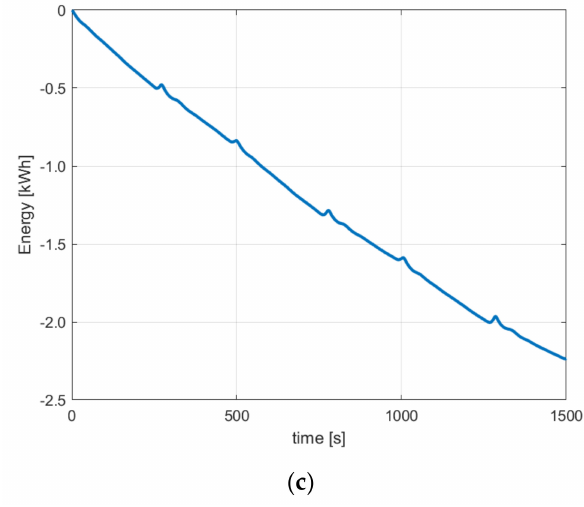
Figure 9. Example of test results for charging mode 2. ( a ) Temperatures of HTF and R410a; ( b ) tem- peratures of PCM; ( c ) energy supplied during the